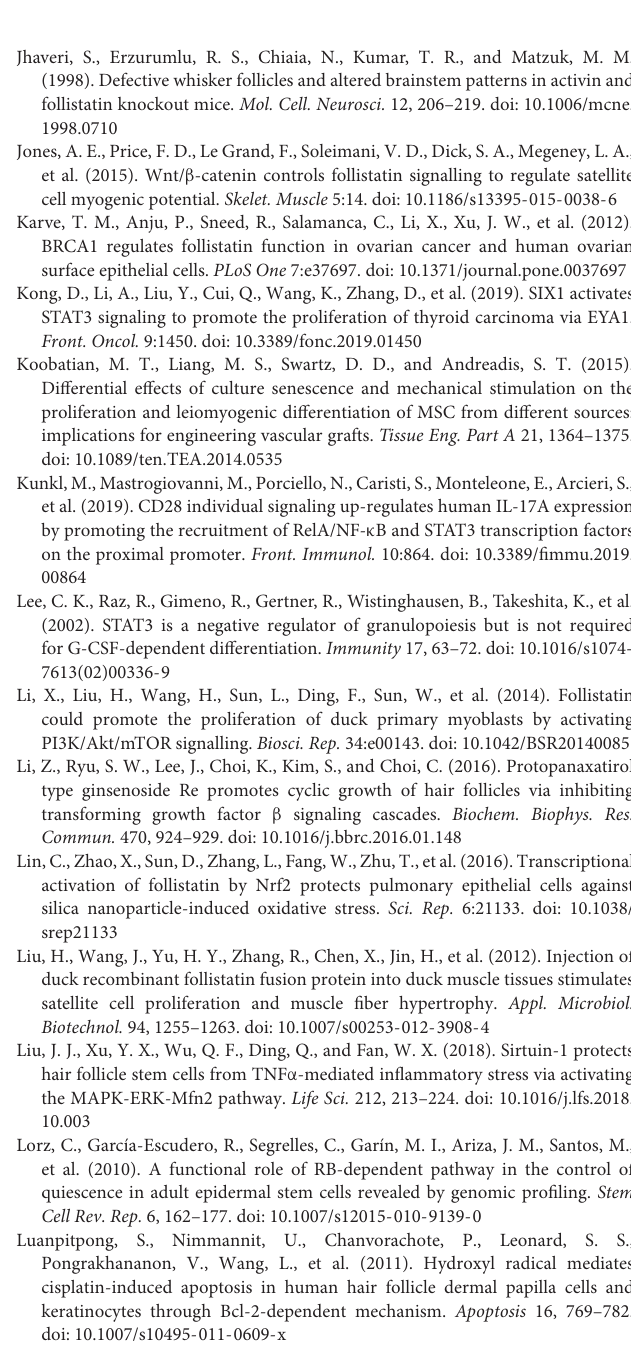
Supplementary Figure 1 | Determination of the genomic gap upstream of sheep FST gene by genome walking. The three reverse primers, FST -SP1, FST -SP2, Supplementary Table 1 | Primers used in this study. Supplementary Table 2 | Original